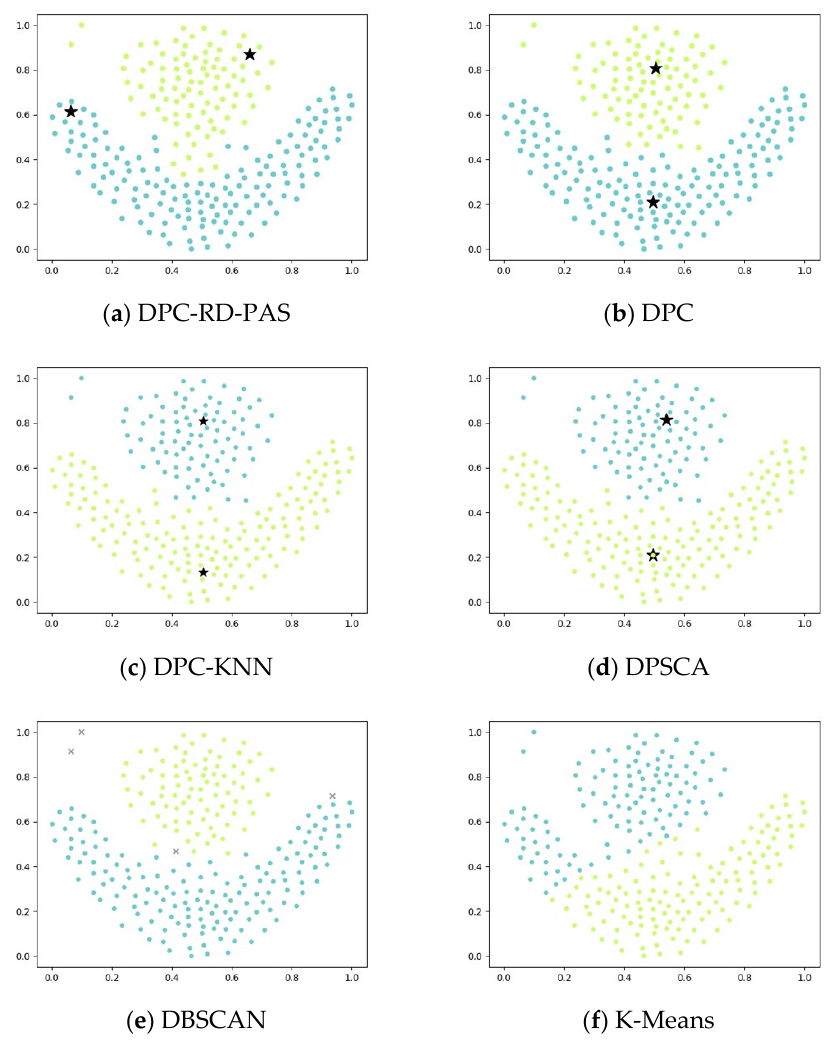
Figure 8. Clustering results on the Flame dataset.